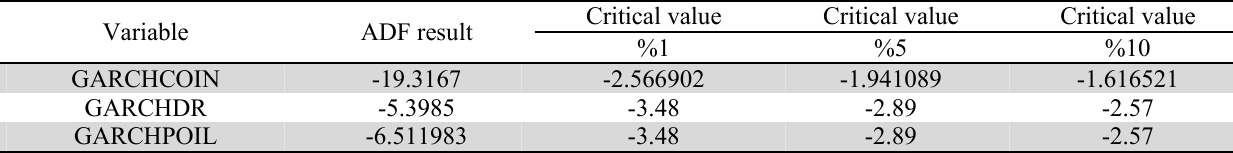
The results ADF test